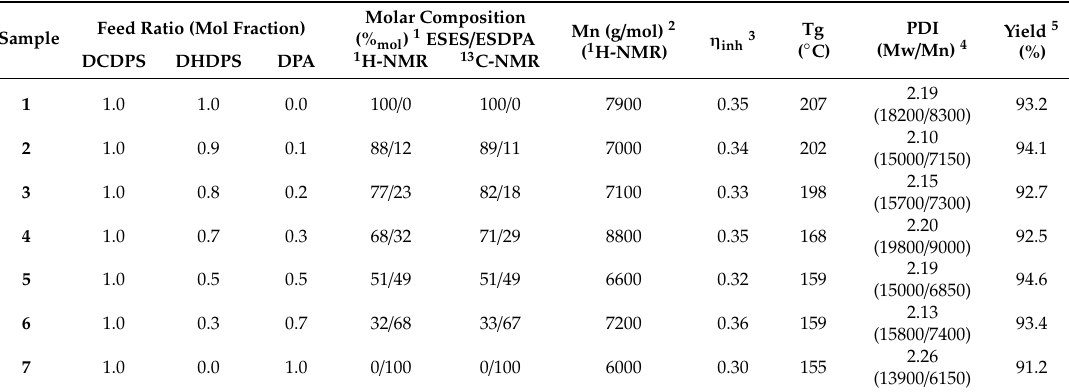
Table 1. Some properties of the Poly(ether sulfone)s